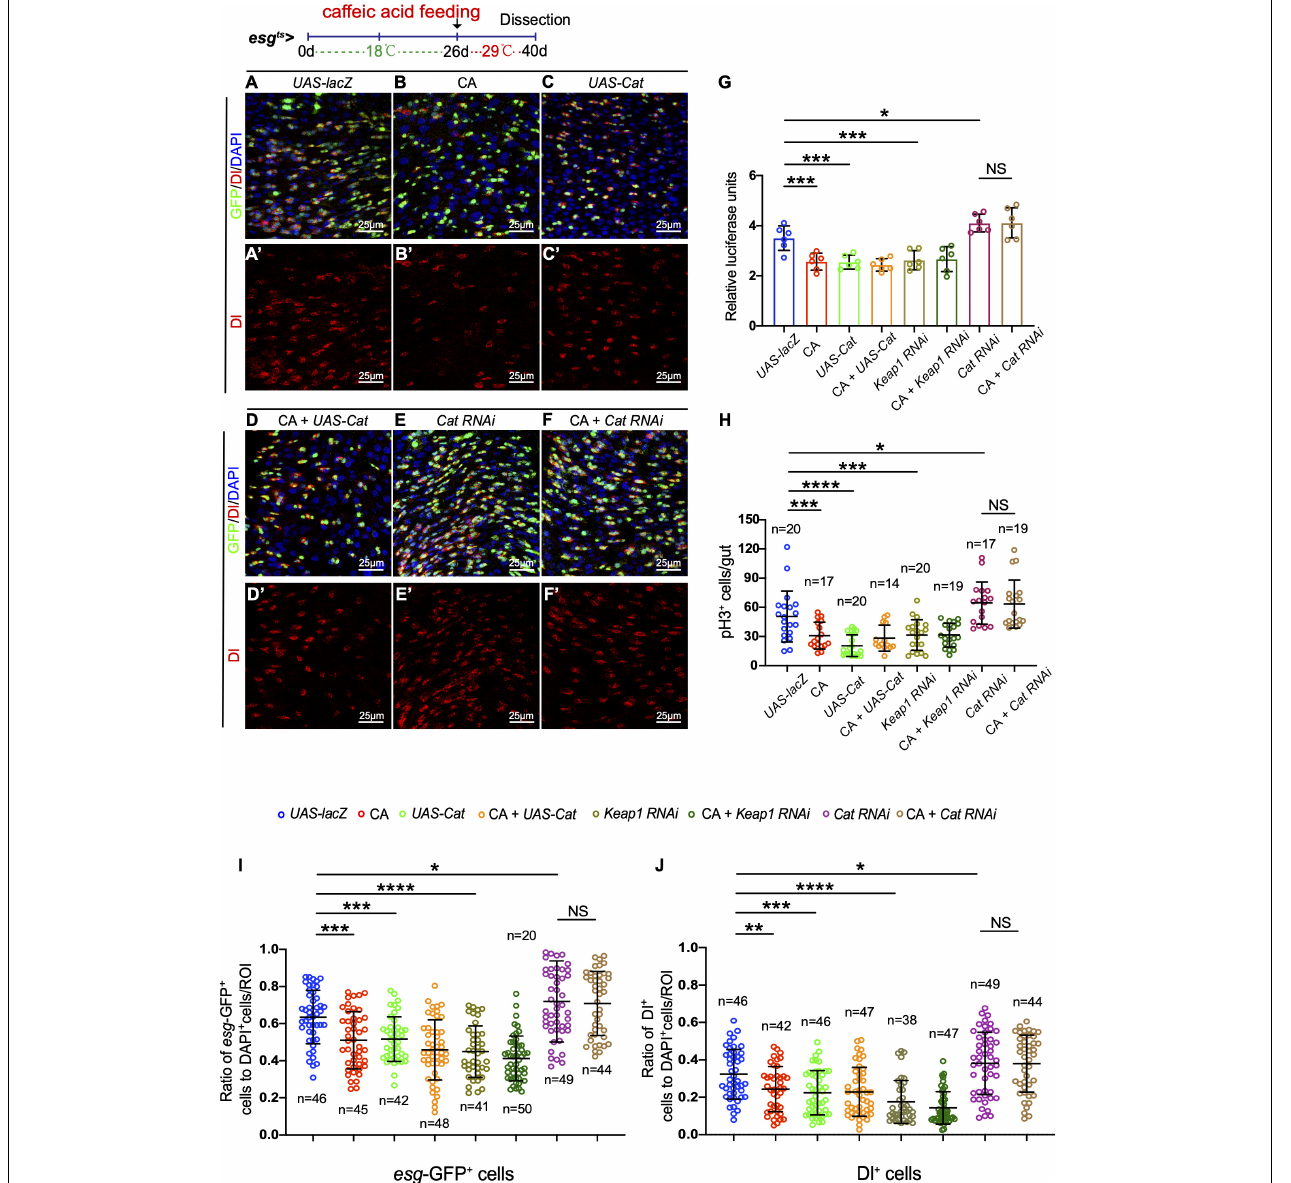
FIGURE 5 | Caffeic acid (CA) prevents ISC aging via antioxidant ability. (A–F) Immunofluorescence images of the R4 region of midguts of Drosophila carrying esg ts -GAL4- driven UAS-lacZ ( A , control), CA (B) , UAS-Cat (C) , UAS-cat with CA (D) , Cat RNAi (E) , Cat RNAi with CA (F) , esg -GFP (green; ISC and EB markers), and Dl (red; ISC marker). Panels (A–F) represent merged images and panels (A’–F’) are for Dl (red) only. 29 ◦ C was used to induce transgene expression (see also “Materials and Methods” section). (G) Quantification of the luciferase activity of Drosophila midguts with indicated genotypes and treatment. Error bars represent the SD of six independent experiments. (H) Quantification of the number of pH3 + cells of flies with indicated genotypes and treatment. N (from left to right) = 20, 17, 20, 14, 20, 19, 17, and 19. (I) Quantification of the number of esg -GFP + cells of flies with indicated genotypes and treatment. N (from left to right) = 46, 45, 42, 48, 41, 50, 49, and 44. (J) Quantification of the number of Dl + cells of flies with indicated genotypes and treatment. N (from left to right) = 46, 42, 46, 47, 38, 47, 49, and 44. DAPI stained nuclei are shown in blue in panels (A–F) . Scale bars represent 25 µ m in panels (A–F) . Error bars represent SDs. One-way ANOVA test, * P < 0.05, ** P < 0.01, *** P < 0.001, **** P < 0.0001, and non-significant (NS) represents P >